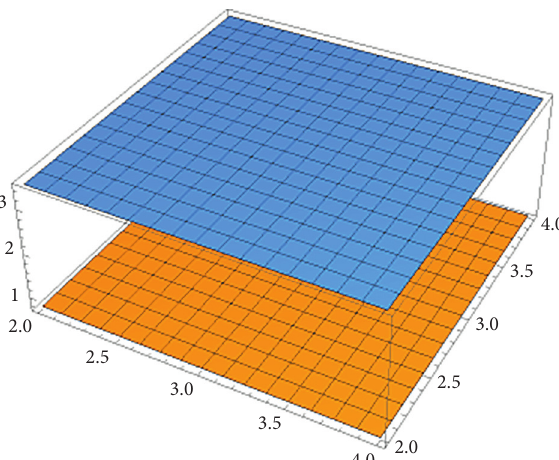
Figure 4: Dominance of right-hand side of equation (30) is visually checked for τ , υ ∈ [ 2 , 4 ]